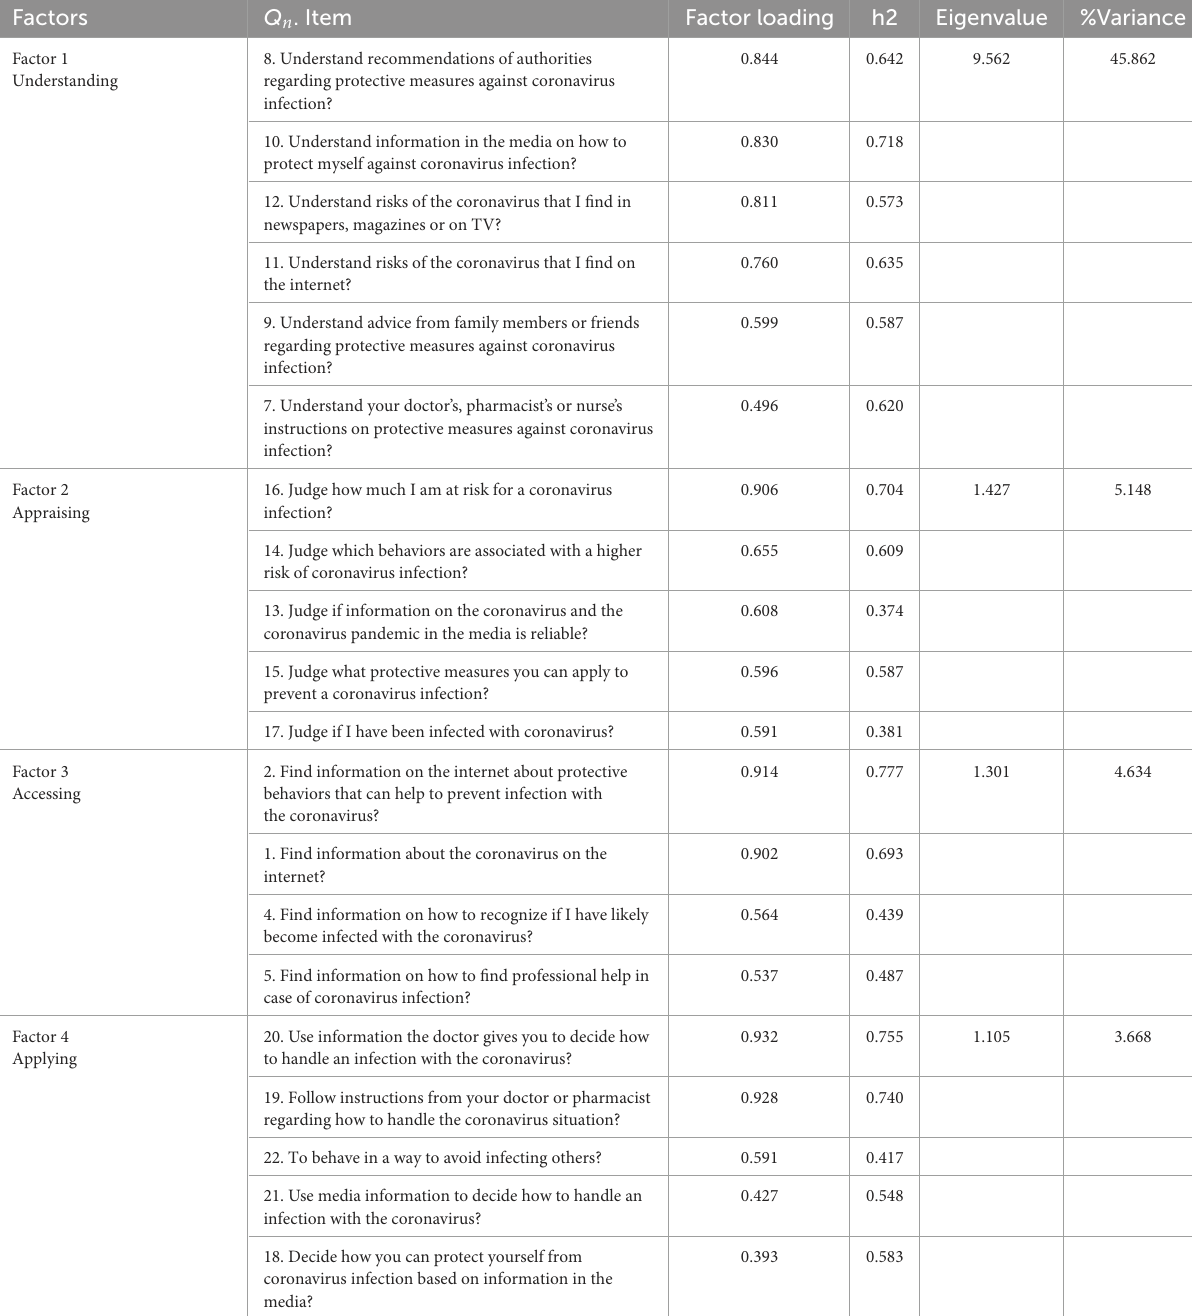
TABLE 2 Exploratory factors extracted from items of COVID-19-health literacy ( n = 440).